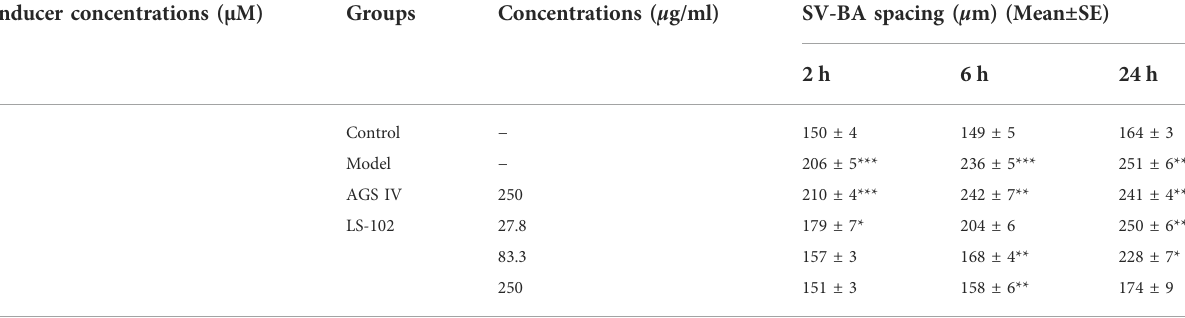
TABLE 5 Quantitative results of LS-102 and AGS IV on SV-BA spacing after astemizole induction in zebra fi sh (n = 10). Inducer concentrations